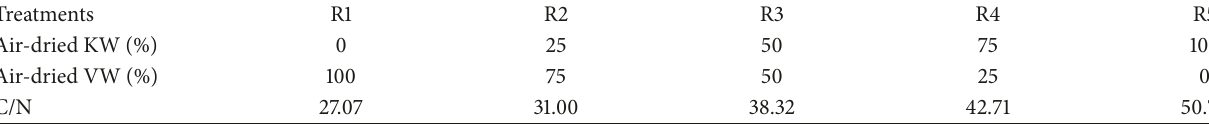
Table 1: The material composition and C/N ratio for the five composting treatments.